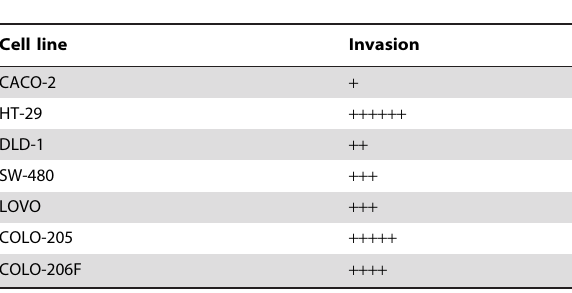
Table 2. Invasive capacity of CRC cell